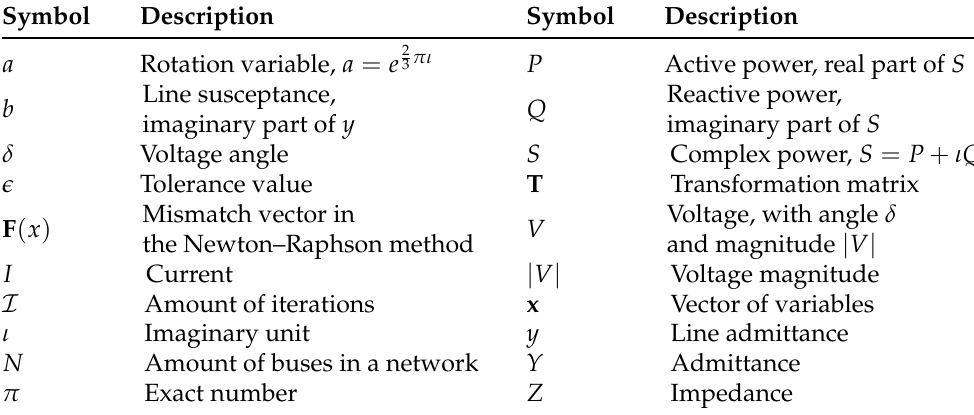
Table A1. List of mathematical symbols including their meaning.